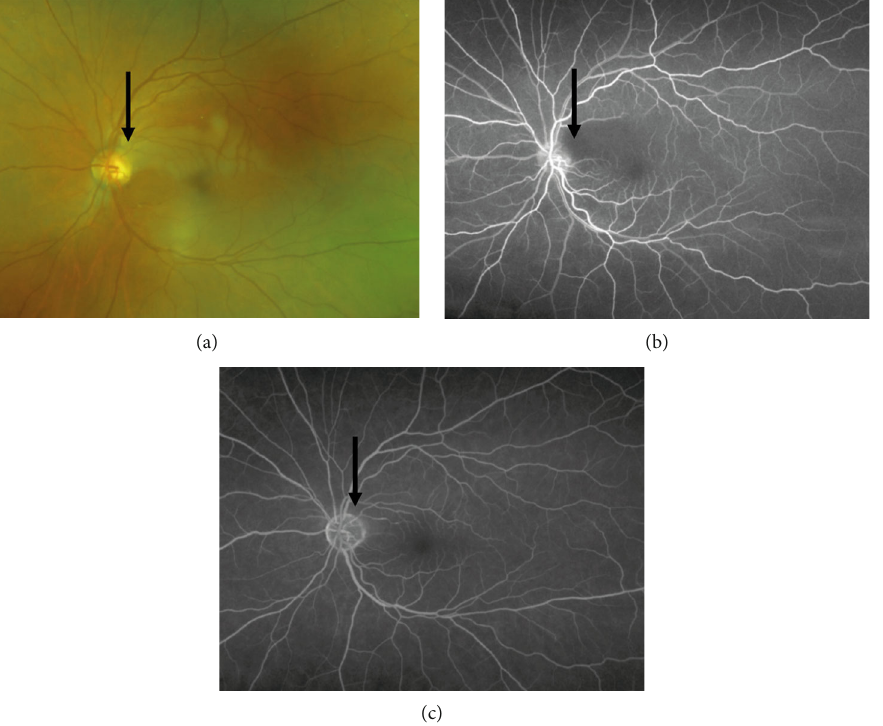
Figure 2: Fluorescein angiography (FA). (a) The left ocular fundus photograph. As in the fundus examination, the image shows a cilioretinal artery originating from the optic nerve papillae. White changes (arrow) are seen in the retina around the cilioretinal artery. (b) The image 20 s after the start of FA. Fluorescein staining of the cilioretinal artery was delayed (arrow). Subsequently, the cilioretinal artery was gradually re fl uxed from the distal side. (c) The image at 2min and 39 s after the start of FA. The area around the cilioretinal artery was